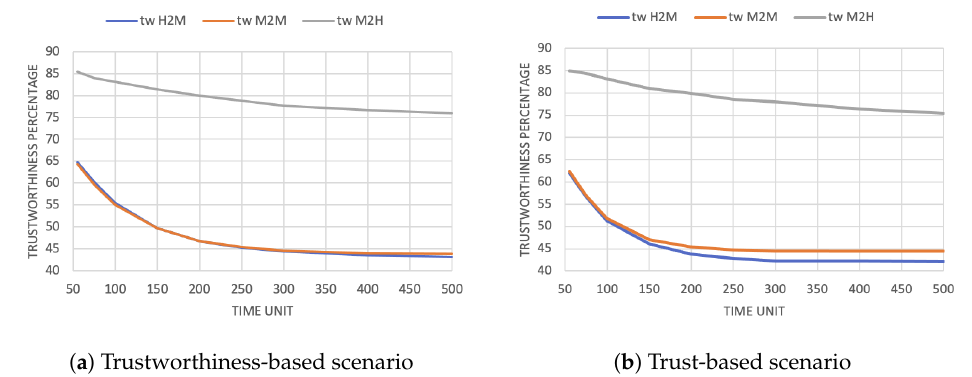
Figure 6. Average trustworthiness evaluation with 25% request